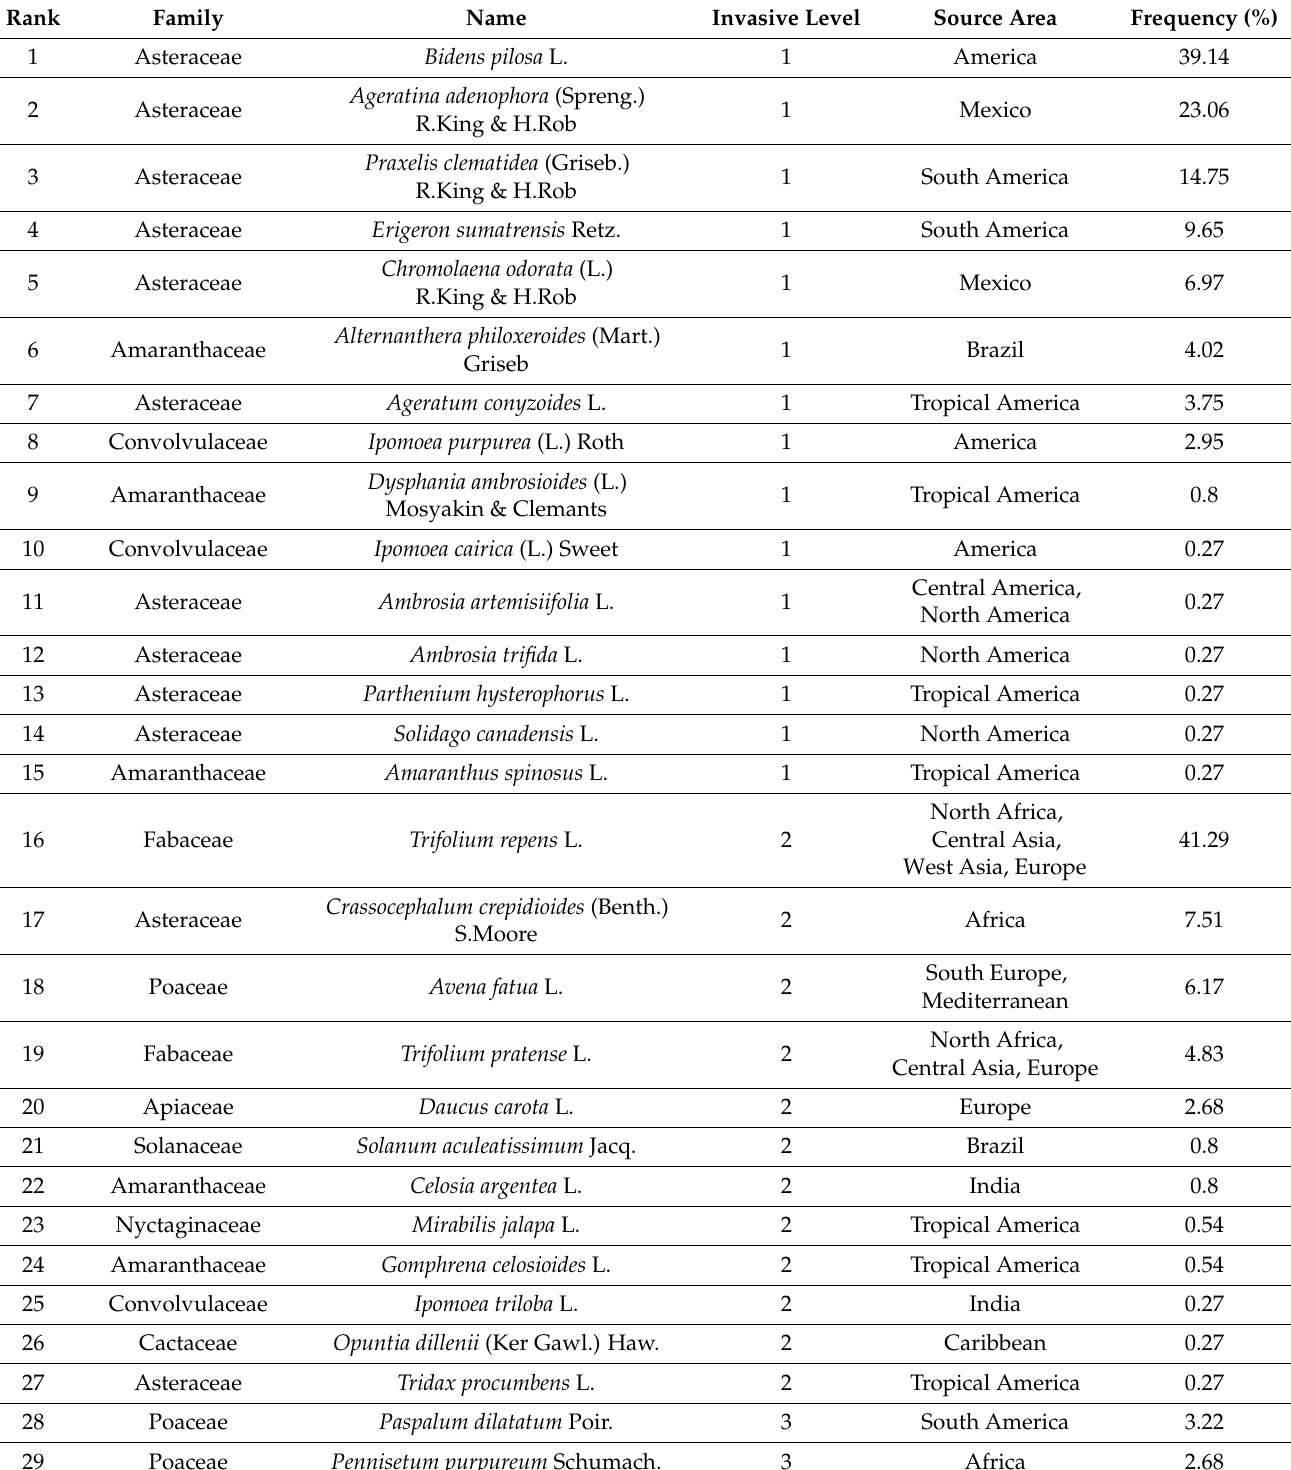
Table 2. Catalogue of invasive plants in grasslands of Guizhou Province, Southwest China. The five invasion levels are as follows: malignant invasion (Level 1), serious invasion (Level 2), local invasion (Level 3), general invasion (Level 4), and plants requiring further observation (Level 5)